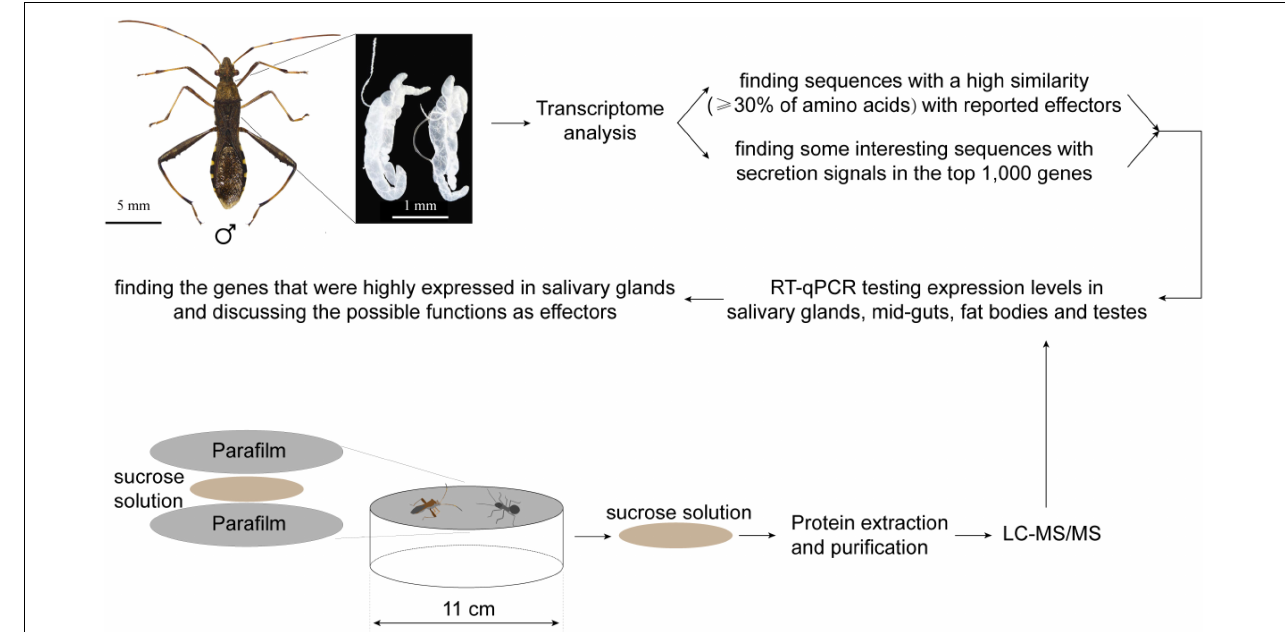
FIGURE 1 | The procedure of the experiment and sequence analyses: salivary glands were dissected from the bean bugs (taking a male as an example here), and then the transcriptome was sequenced and analyzed. We tested the tissue-specific expression of 18 genes with secretion signals in the top 1,000 expressed genes, as well as 19 homologs of reported effectors of other sap-feeding arthropods. In addition, saliva of the bean bugs were collected and the proteomes were analyzed by LC-MS/MS. The tissue-specific expression of 31 secreted salivary proteins was tested. The genes that are expressed more in salivary glands have a high potential as effectors, and their functions were discussed in the